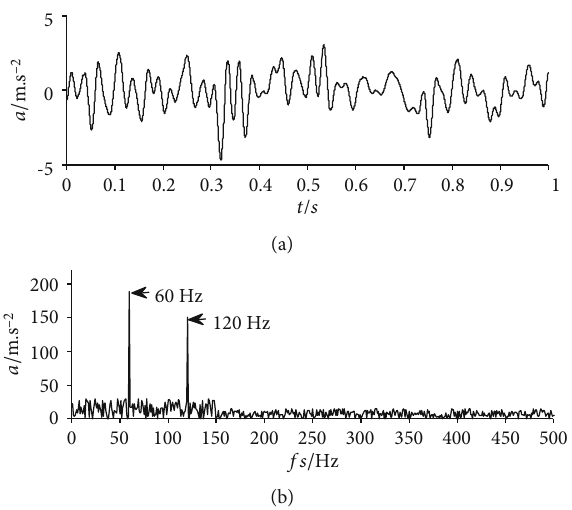
Figure 5: Waveform and frequency spectrum of the simulated signal denoised by the adaptive multiscale combined morphological fi lter.